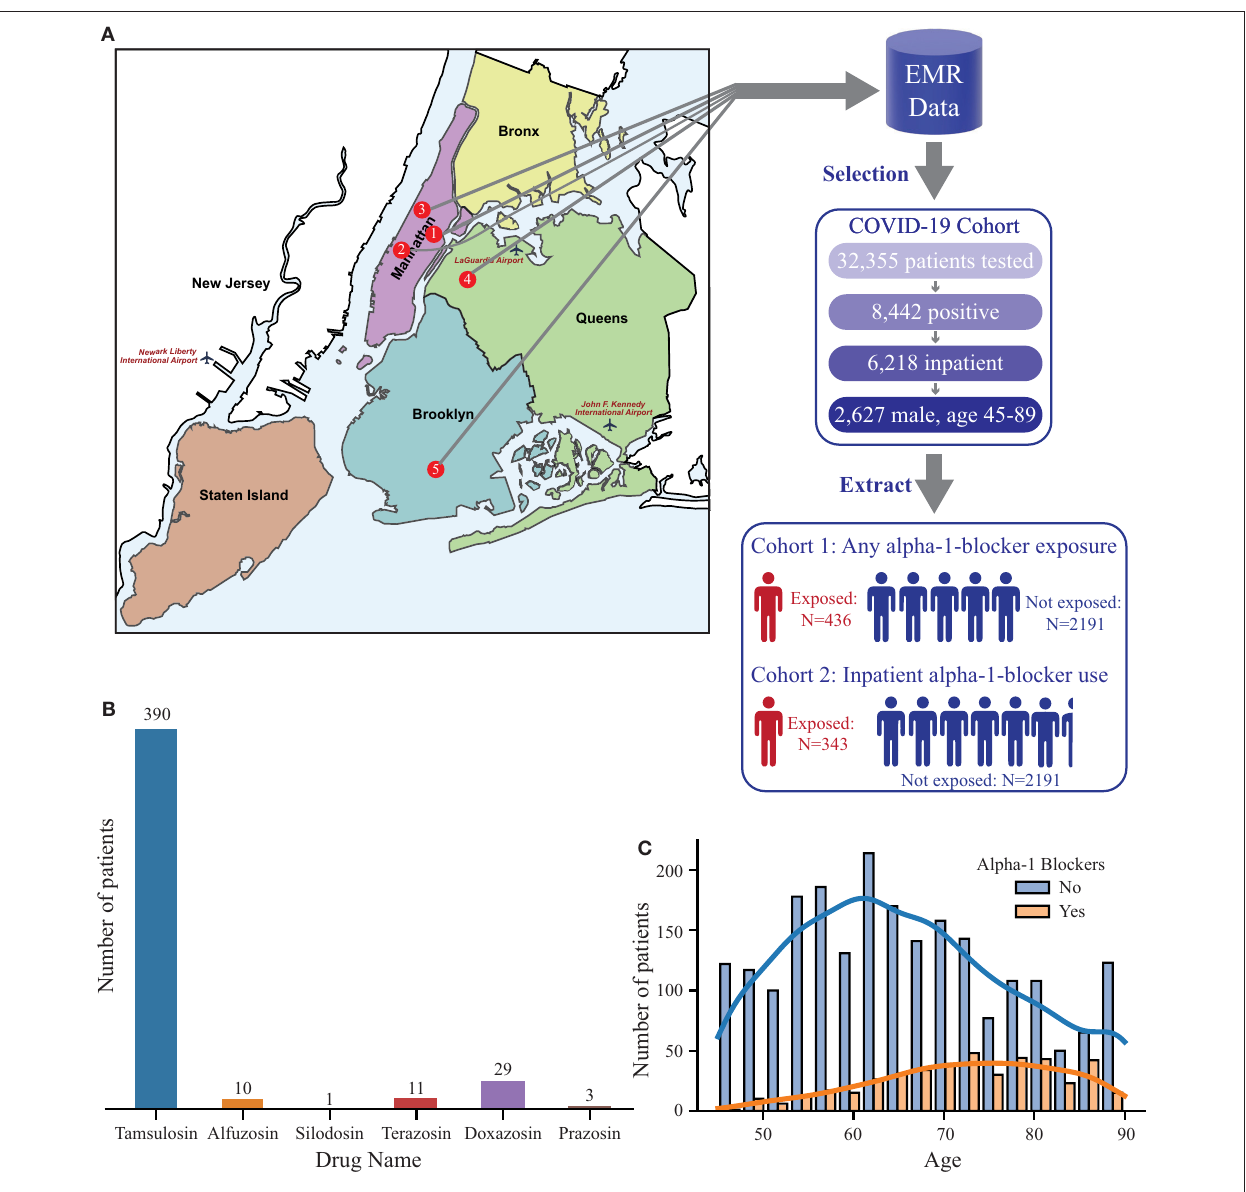
FIGURE 1 | Study design and overview. (A) Schematic flowchart of data extraction and analysis plan. Data was collected from five Mount Sinai hospitals: 1) The Mount Sinai Hospital, 2) Mount Sinai West, 3) Mount Sinai St. Luke’s, 4) Mount Sinai Queens, and 5) Mount Sinai Brooklyn. A total of 32,355 patients were tested, of which 2,627 were positive, inpatient, and male ages 45-89. Data was extracted for the 2,627 male, age 45-89 patients and split into two cohorts: 1) any alpha-1-blocker exposure and those not exposed and 2) inpatient alpha-1-blocker exposure and those not exposed. The image of the boroughs of NYC was adapted from https://commons.wikimedia.org/wiki/File:New_York_City_District_Map.svg, which is under a Creative Commons Attribution-Share Alike 2.5 Generic license. (B) Prevalence of various alpha-1-blockers in the exposed cohort. (C) Age distribution of those exposed to alpha-1-blockers (red) and those not exposed